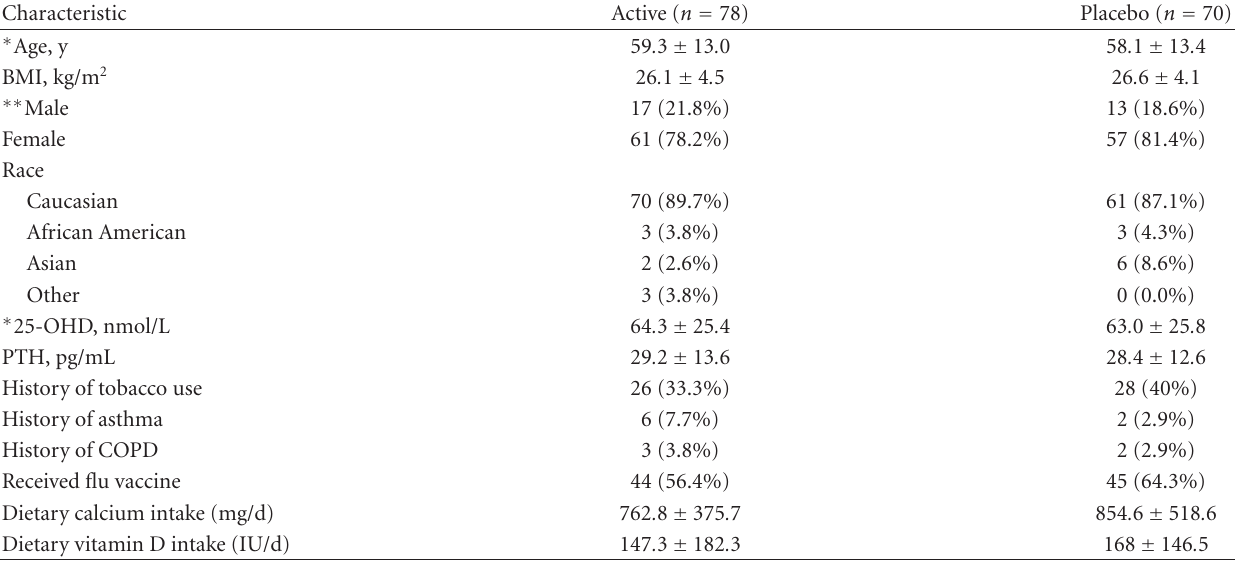
Table 1: Baseline characteristics of study participants. There were no significant di ff erences between the study groups at baseline.